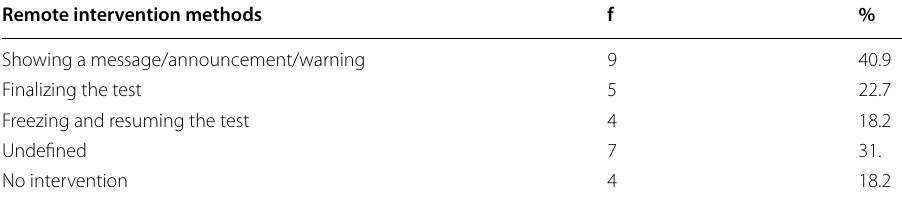
Table 8 Remote intervention methods used in online assessment systems Remote intervention